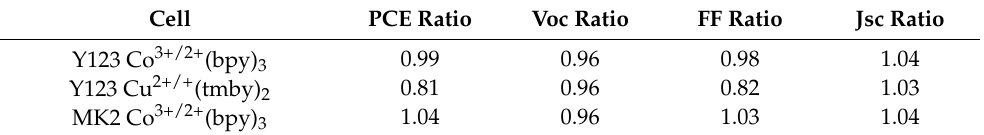
Table 2. The ratios of photovoltaic parameters measured after and before 30 min continuous irradiation. Cell PCE Ratio Voc Ratio FF Ratio Jsc Ratio Y123 Co 3+/2+ (bpy)